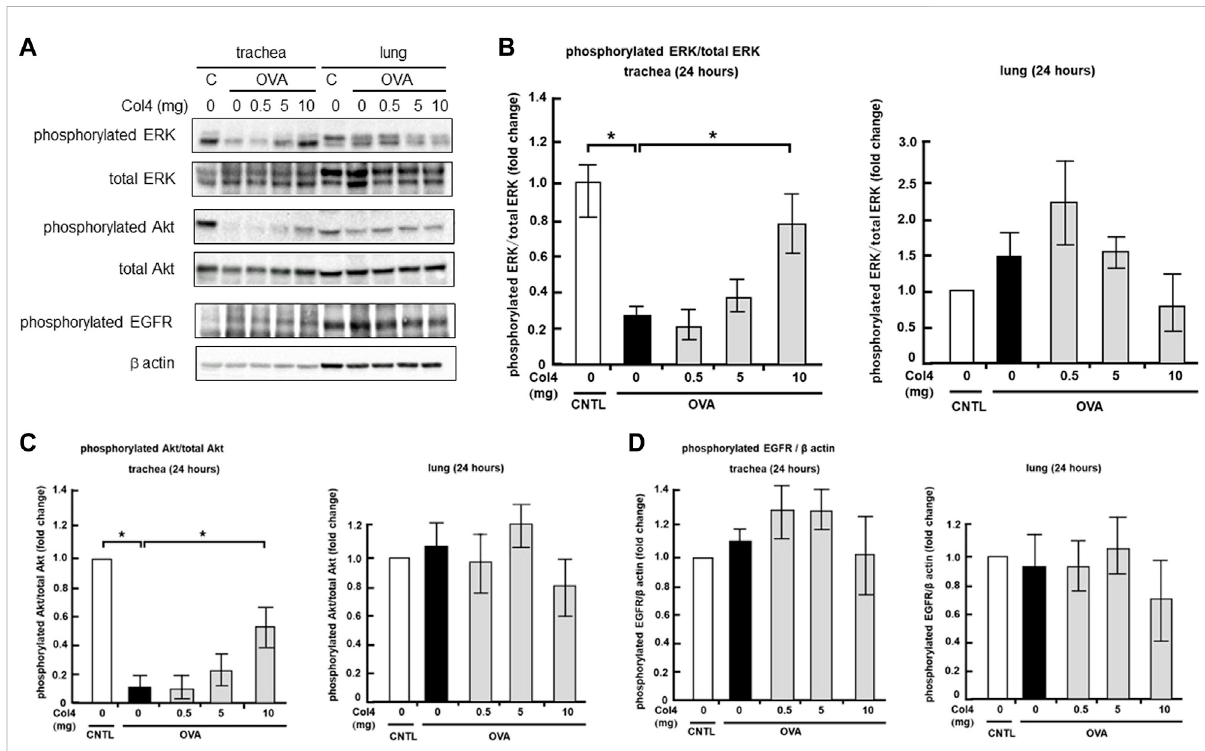
FIGURE 8 EffectsofCol4ontheactivitiesofextracellularsignal-regulated kinase(ERK), Akt,phosphorylatedepidermalgrowth factorreceptor(EGFR)and β actinlevelsinovalbumin(OVA)-sensitizedandunsensitizedcontrolmice. (A) Thecontrolmice(C)andOVA-sensitizedmice(OVA)wereexposedto Col4 at various concentrations (0 – 10 mg). After 24 h of Col4 exposure, the trachea, and lungs were sampled and phosphorylated ERK, total ERK, phosphorylated Akt, total Akt, phosphorylated EGFR, and β actin levels were detected. Graphs show the relative levels of phosphorylated ERK per total ERK (B) , phosphorylated Akt per total Akt (C) and phosphorylated EGFR per β actin (D) compared with the control. Representative results of three independent experiments are presented. The control mice and the mice treated with 0 mg of Col4 were exposed to PBS alone at the same